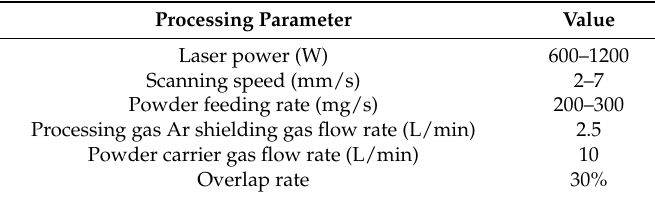
Table 2. The laser parameters used in the present